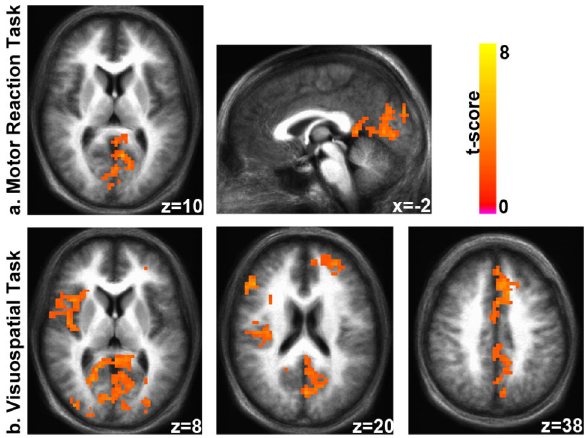
Figure 5. MSSD Group Comparisons. MSSD contrast maps for motor reaction (a) and visuo-spatial (b) task. Yellow/red regions indicate significantly ( p < 0.05, whole brain corrected) greater BOLD variability in professional as compared to naïve drivers. No regions showed significantly greater MSSD in naïve